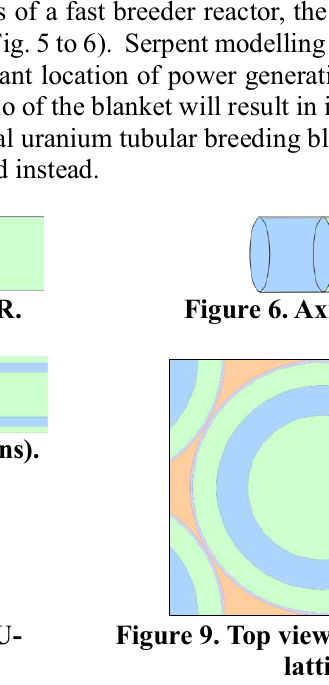
Figure 4. Axial cross-sectional illustration of a BBMSR fuel tube (top half sectional view).